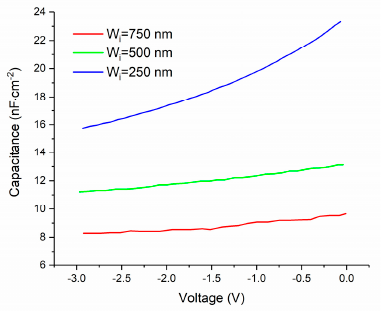
Figure 6. Capacitance–voltage measurement results measured with 1 MHz AC signal for p-Si/i-ZnO/n-AZO structure.